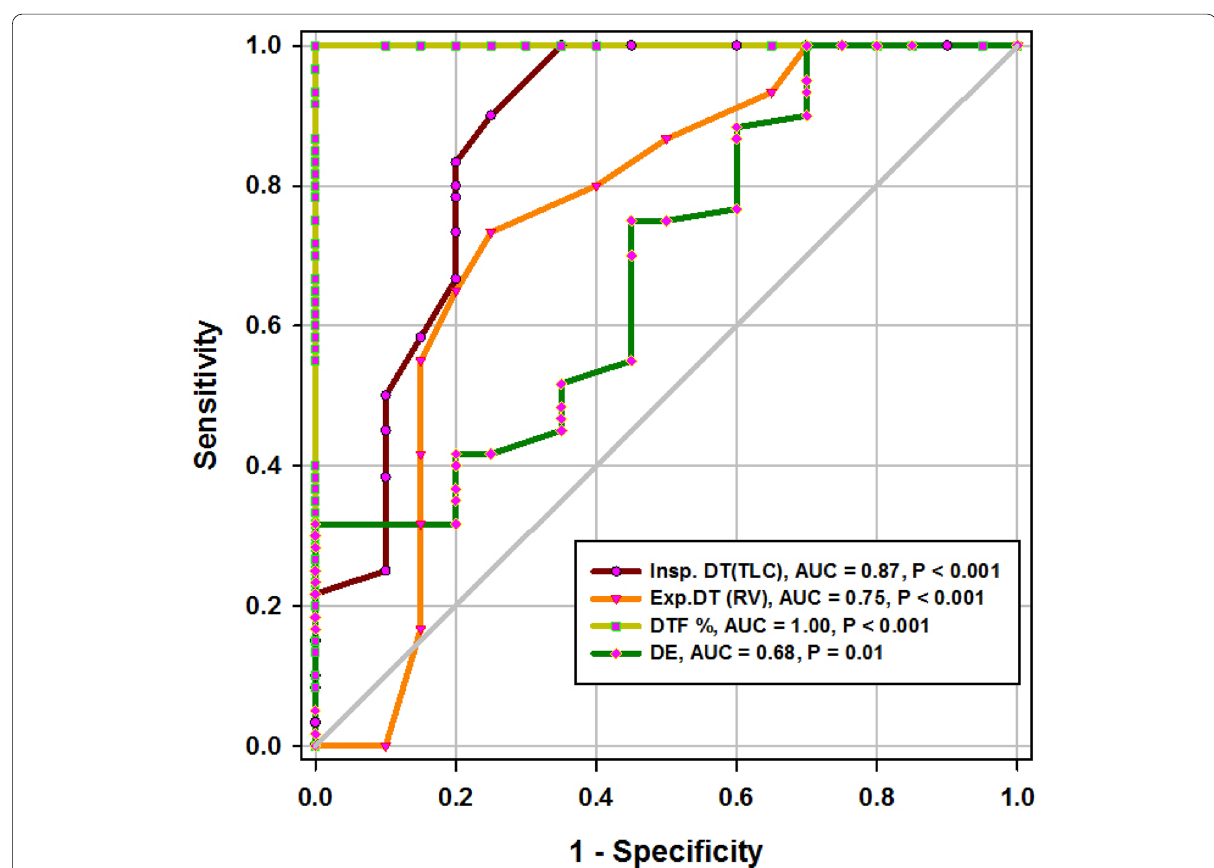
Fig. 4 ROC curve of diaphragmatic parameters during deep